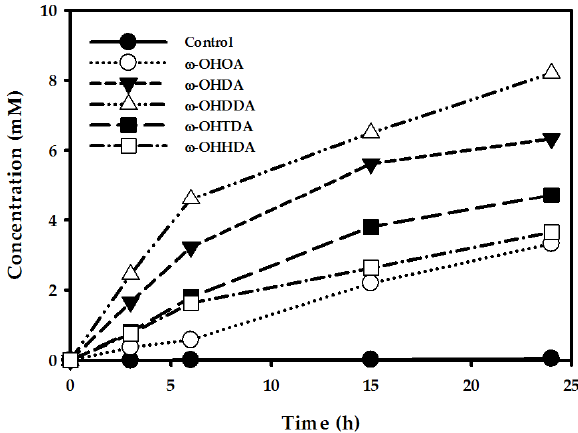
Figure 5. In vivo production of ω‐ OHFAs using E. coli BW25113 ( ∆ fadD, DE3) cells expressing MaqCYP153A33 and CamAB. Reaction conditions: Substrate, 10 mM FFAs (C 8 –C 16 ); Volume, 50 mL in 250 mL flask; Temp, 30 °C; Buffer, 100 mM potassium phosphate buffer (pH: 7.5) with 1% glucose ( w / v ); and Cell OD 600 , 30. ω‐ OHOA, ω‐ hydroxy octanoic acid; ω‐ OHDA, ω‐ hydroxy decanoic acid; ω‐ OHDDA, ω‐ hydroxy dodecanoic acid; ω‐ OHTDA, ω‐ hydroxy tetradecanoic acid; ω‐ OHHDA, ω‐ hydroxy hexadecanoic acid. Control, cells carrying “empty” pET24ma and pETDuet ‐ 1 plasmids (without MaqCYP153A33 and CamAB genes). Values were obtained by triplicate experiment with standard deviations within ≤ 10%.